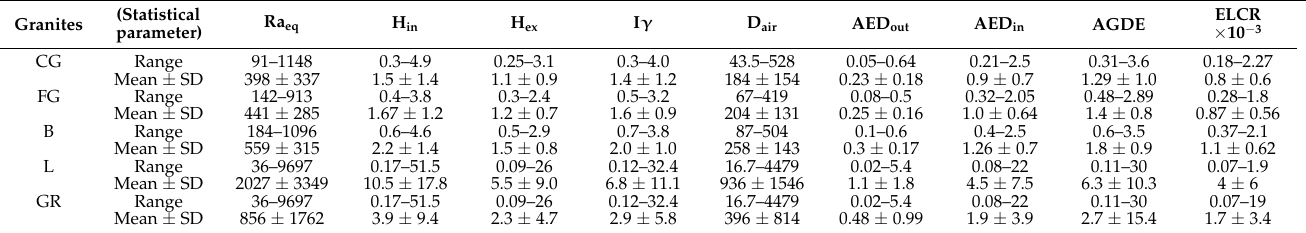
Table 6. Results of different hazard indices associated with the radioactivity of granitic rocks at Sol Hamed, Southeastern Desert,